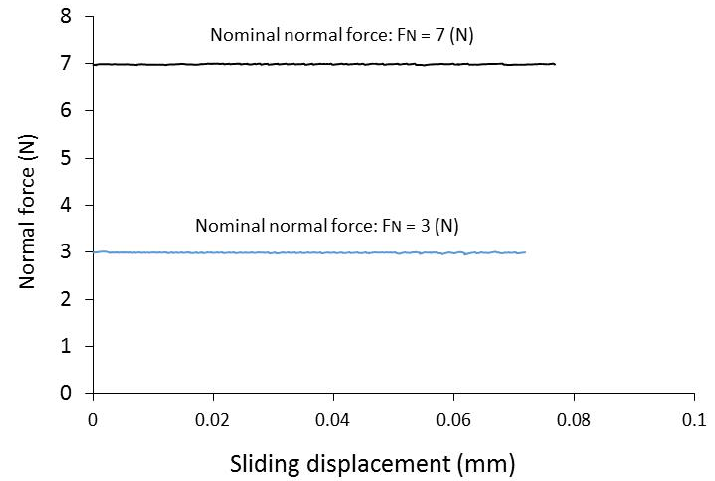
Figure 4. Typical plots of normal force against sliding displacement during inter-particle shearing tests on LBS grains.